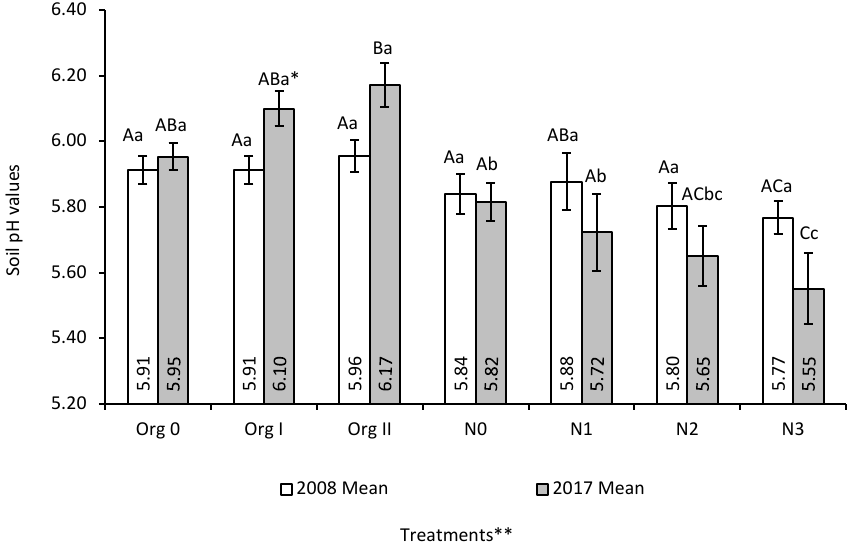
Fig. 3. Soil pH values under different treatments at the beginning of the field experiment and after ten years. 2008 Mean: F =1.268, p =0.276; 2017 Mean: F =8.215, p <0.001; (6, 133) (6, 133) *different upper case letters indicate a significant difference between years, and different lower case letters indicate the difference between treatments in a given year; **See explanations under Figure